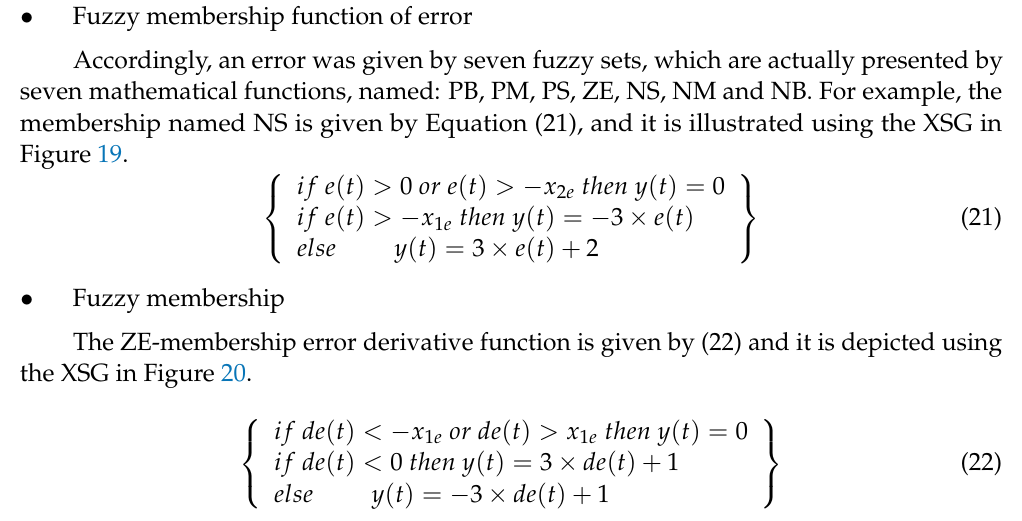
Figure 14. Hardware design of VCS-PI controllers for grid-side converter. Where (*) is added to distinguish between the actual and the references variables.